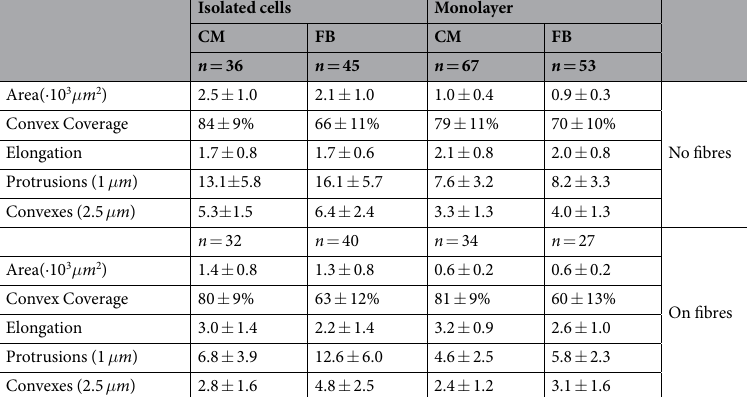
Table 1. Cell shape characteristics measured in the experiment.